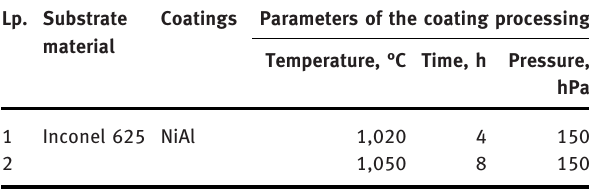
Figure 1: The diagram of sample preparation for fracture